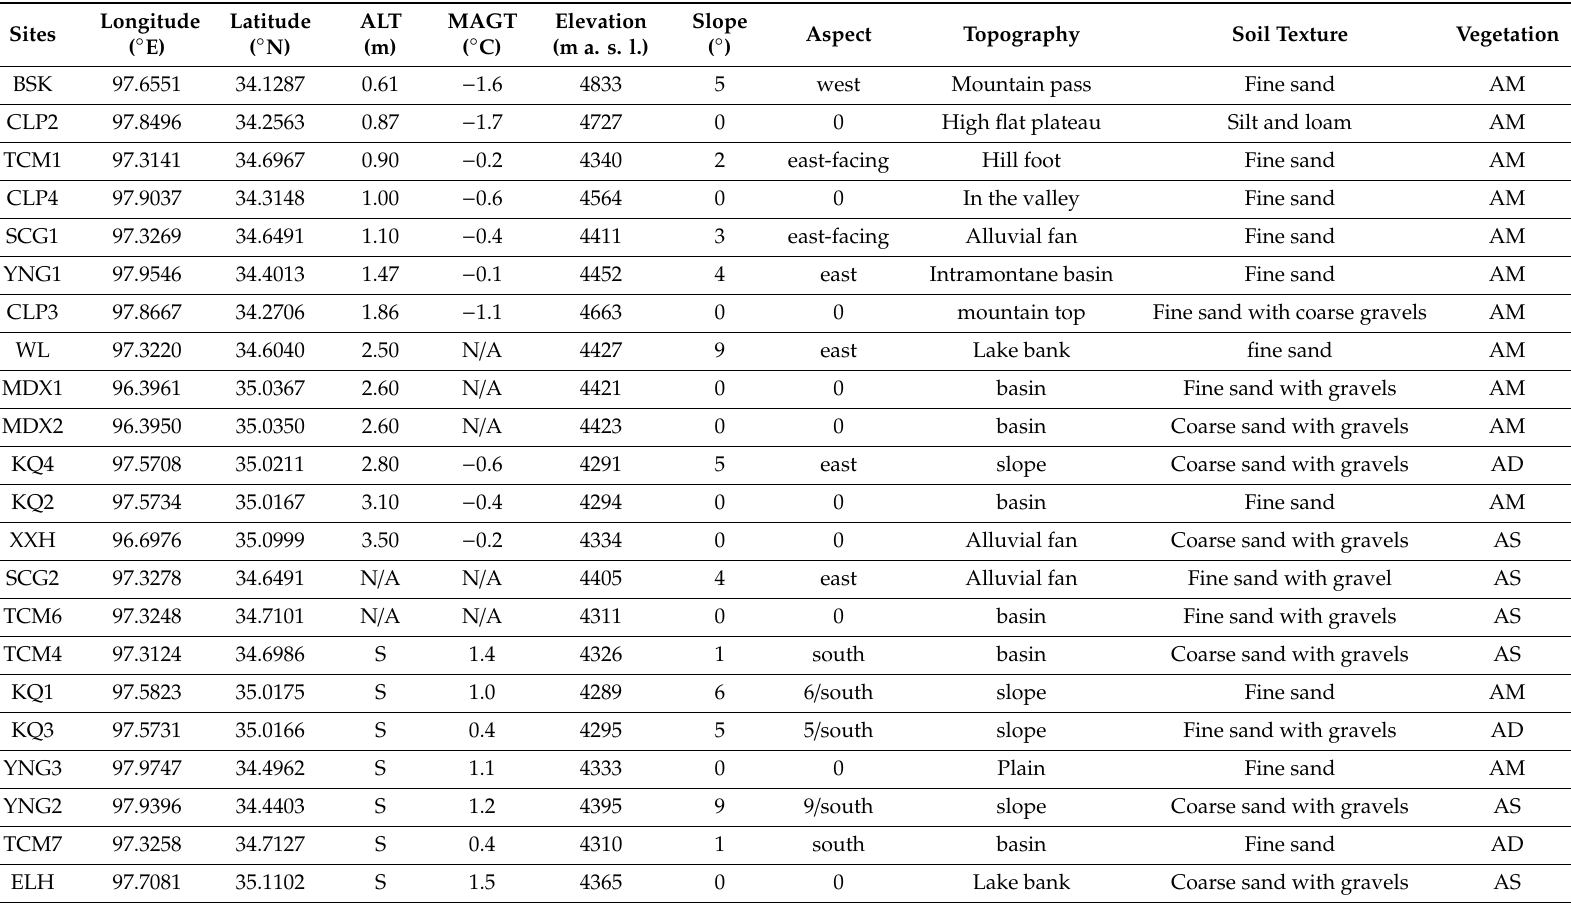
Table 1. Site information in permafrost and seasonally frozen ground in the study